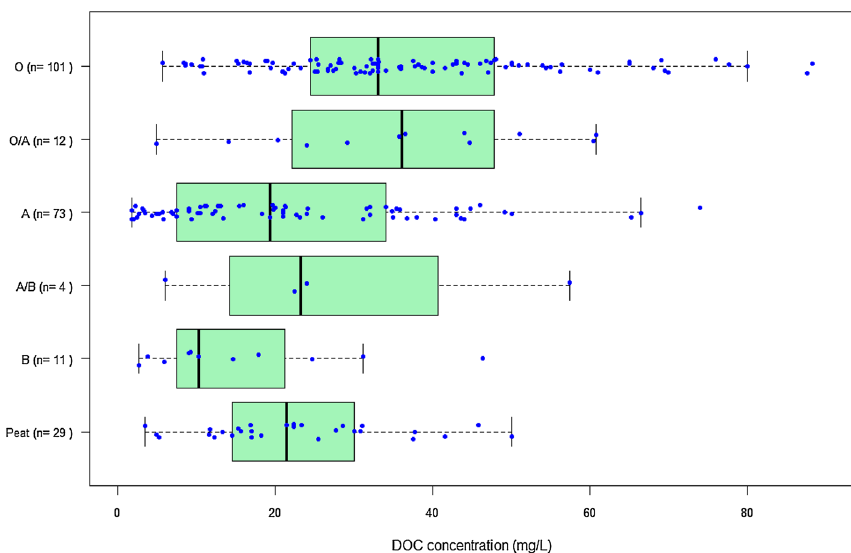
Fig. 6 Topsoil DOC concentra- tion (mg C L −1 ) data distributed over horizon classes (n = 230, 90% of all topsoil DOC con- centration data). Laboratory incubation data are excluded. Boxplot bars are medians. Whiskers extend up to 1.5 times the interquartile range (IQR) from the lower and upper quartile, unless exceeding the minimum or maximum.